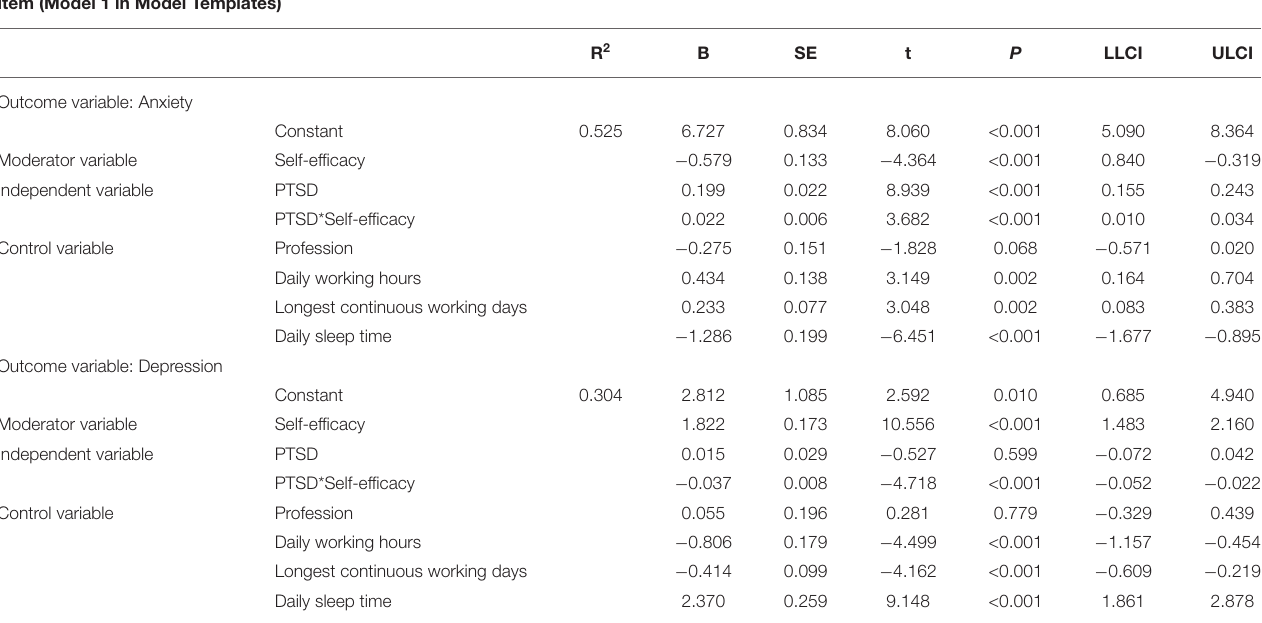
TABLE 5 | Moderation analyses of PTSD.